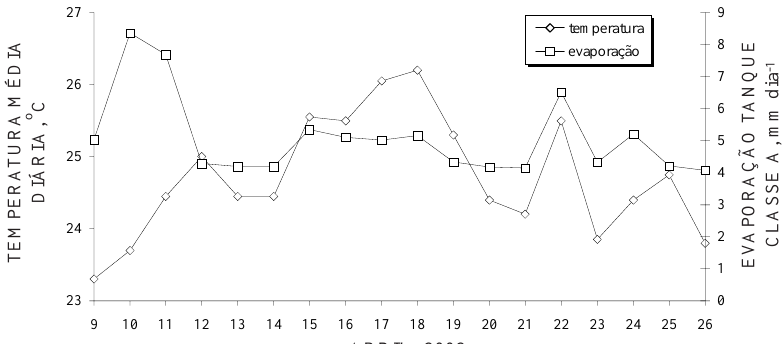
Figura 1. Temperatura média diária ( o C) e evaporação do tanque Classe A (mm/dia) para o período de monitoramento de 9 a 26 de abril de 2002, obtidos no Posto Meteorológico do Departamento de Ciências Exatas da ESALQ/USP, Piracicaba